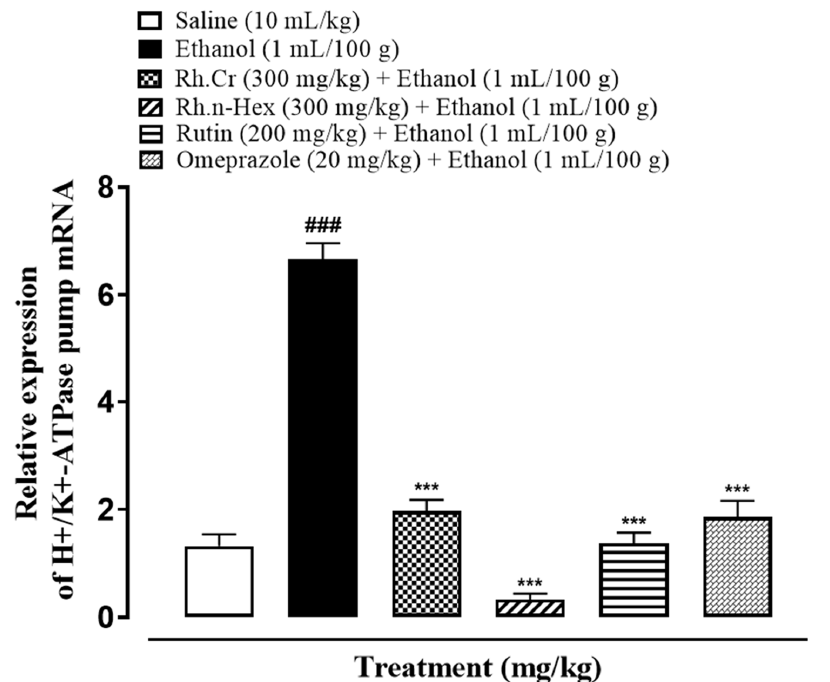
Figure 12. Inhibitory effect of Rumex hastatus crude extract (Rh.Cr), n-hexane (Rh.n-Hex) fraction, rutin and omeprazole against mRNA of H + /K + -ATPase expression in ethanol-treated rats gastric tissues, using Real Time-Polymerase Chain Reaction (RT-PCR) technique. Values are expressed as mean ± SEM ( n = 3). One-way ANOVA with post-hoc Tukey’s test. ### p < 0.001 vs. saline group, *** p < 0.001 vs. ethanol group.